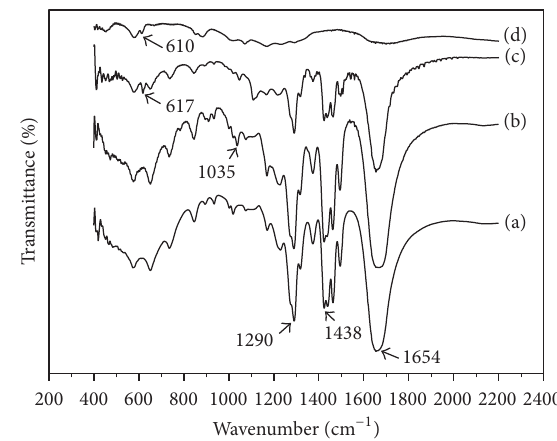
Figure 2: The comparative FT-IR spectra of (a) PVPP, (b) PVPP-BS, (c) [ PVPP-BS ] HSO 4 , and (d) H 2 SO 4